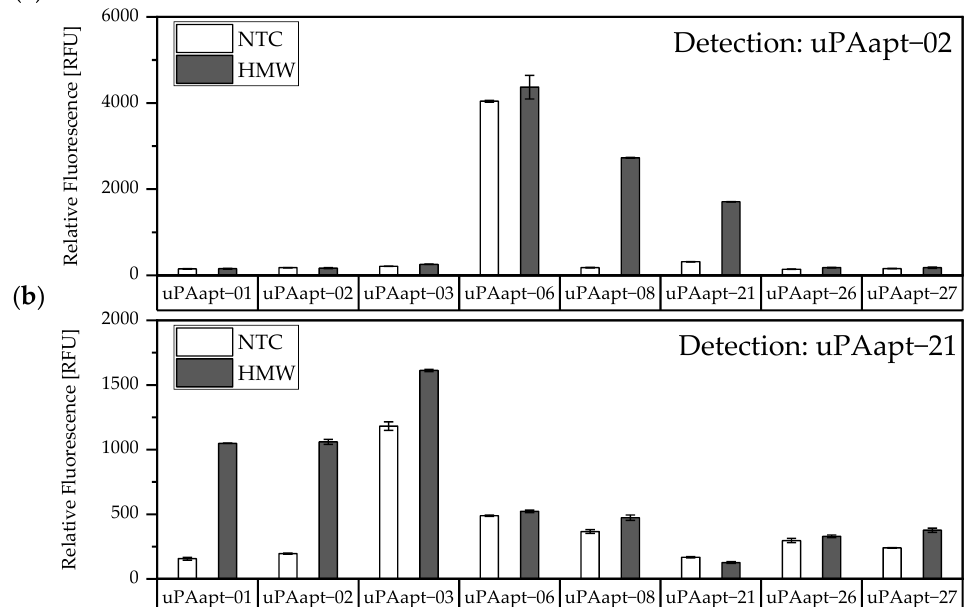
Figure 3. Screening for possible aptamer combinations for detection of HMW-uPA. All aptamers were tested for their use as capture aptamers when ( a ) uPAapt−02 or when ( b ) uPAapt−21 is used as the reporter aptamer. The relative fluorescence unit [RFU] for each sample is shown as the mean value of technical replicates and was measured using the multimode microplate reader Mithras 2 LB 943. Error bars represent the range of measured values. NTC = No Target Control, HMW = HMW-uPA. Number of records n =2.